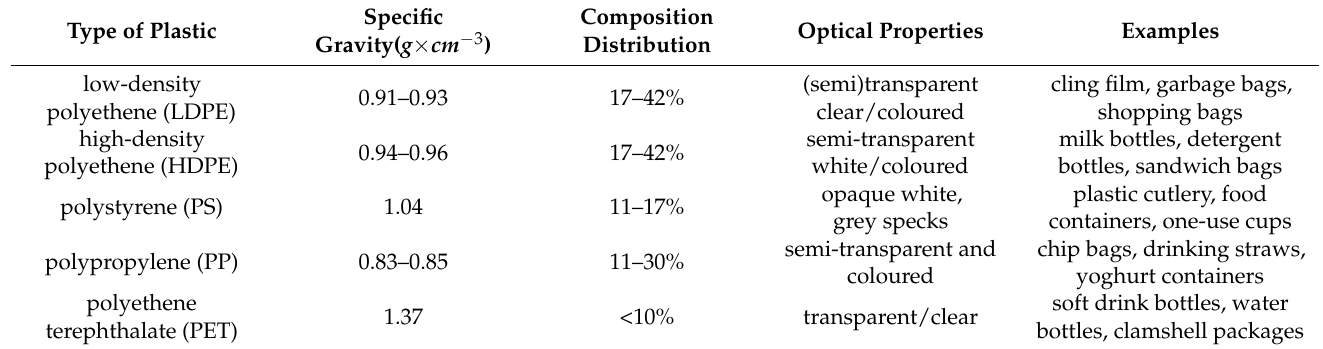
Figure 2. Virgin plastic collection subdivided into five polymer categories and non-plastics. Table 1. Types of plastics in freshwater environments showing density, abundance, and examples of their use.